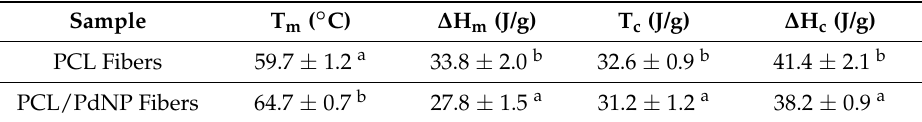
Table 1. Thermal properties obtained by DSC in terms of melting temperature (T m ), normalized melting enthalpy ( ∆ H m ), crystallization temperature (T c ), and crystallization enthalpies ( ∆ H c ) for PCL and PCL/PdNP